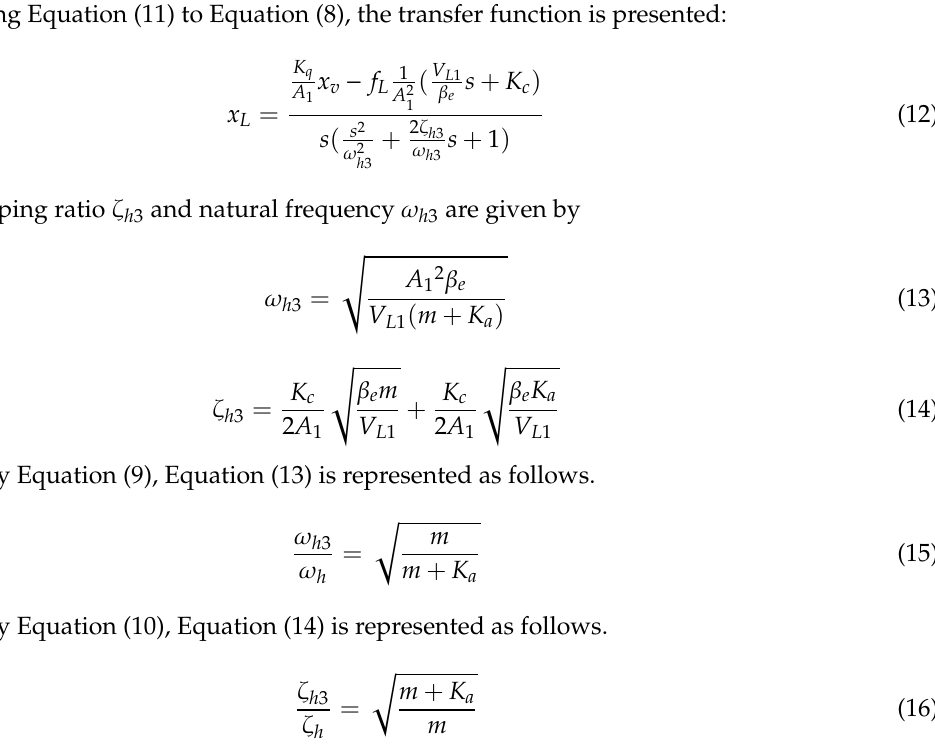
Figure 5. The system block diagram with the active damping strategy.